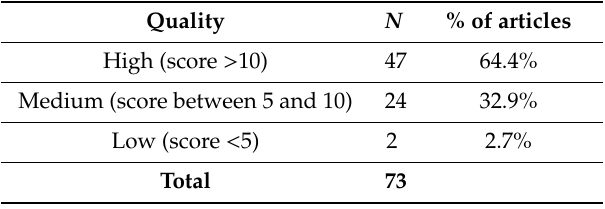
Table 2. Summary of the quality assessment conducted by raters on the articles included in the